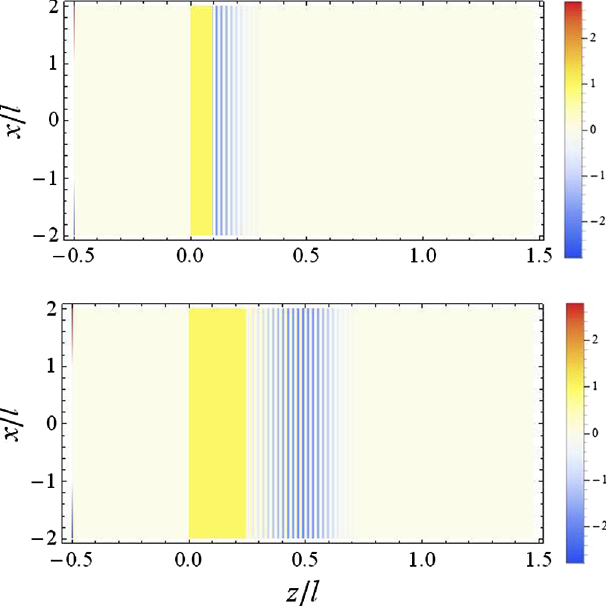
=n 0 under the e